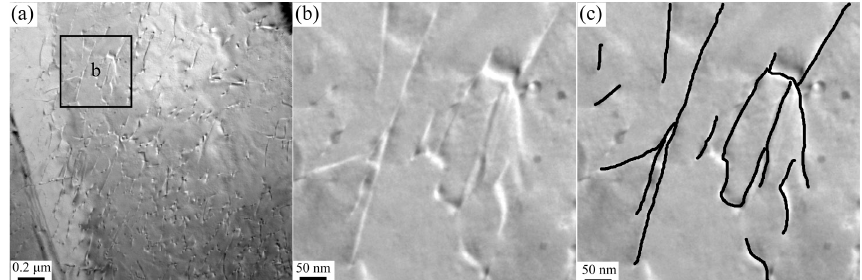
Figure A1. ( a ) Bright-field TEM micrograph of AZ31B where several regions were chosen to measure dislocation density; ( b ) magnification of the area in ( a ) delimited by a black square; ( c ) the same micrograph as in ( b ), where the black lines define the path considered for determination of l p .